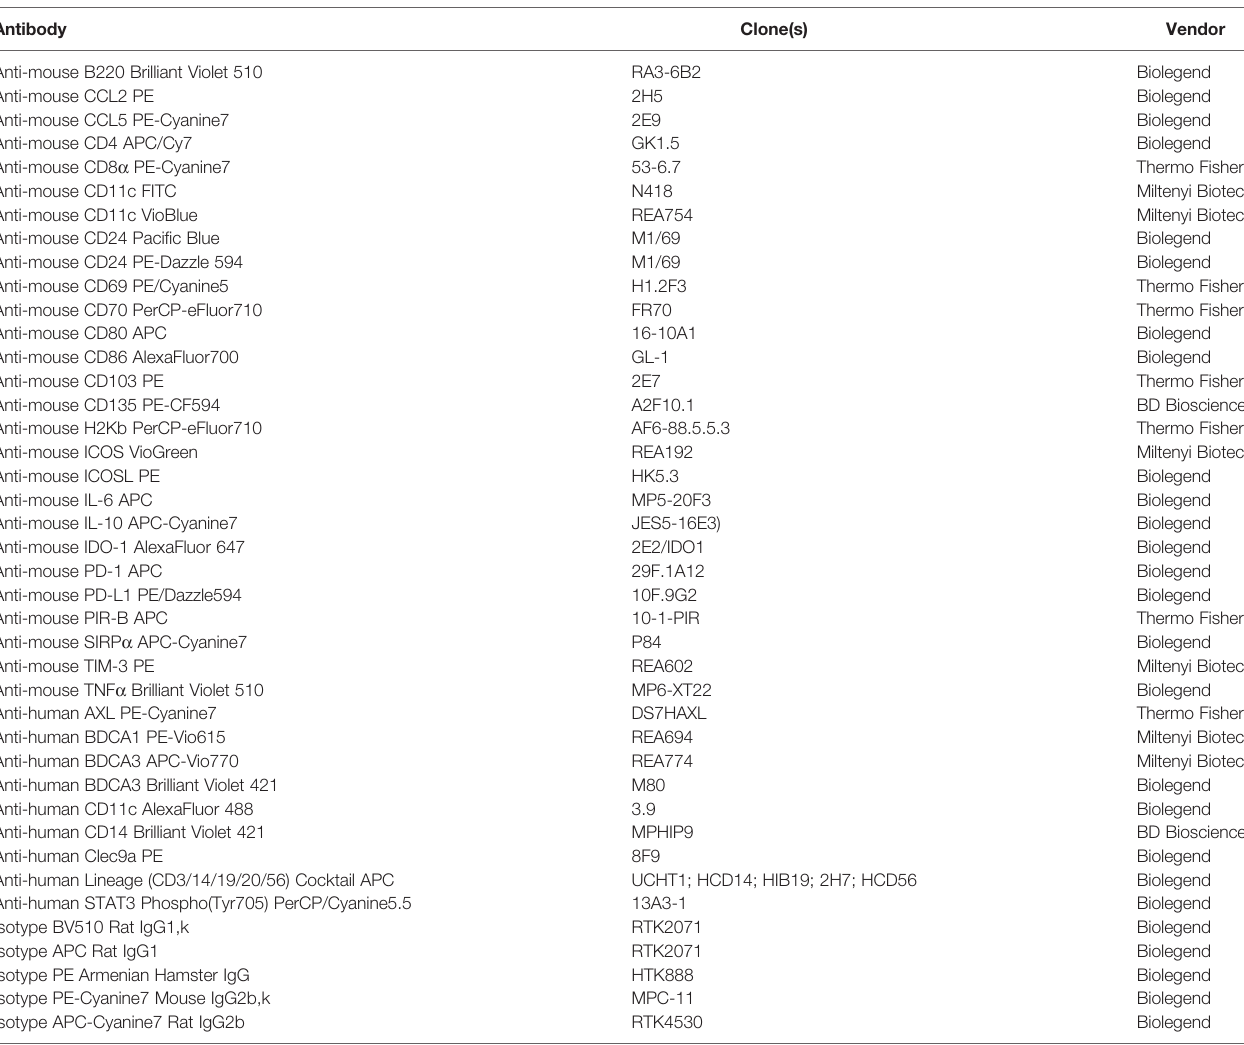
TABLE 1 | Antibodies used for fl ow cytometry. Antibody Anti-mouse B220 Brilliant Violet